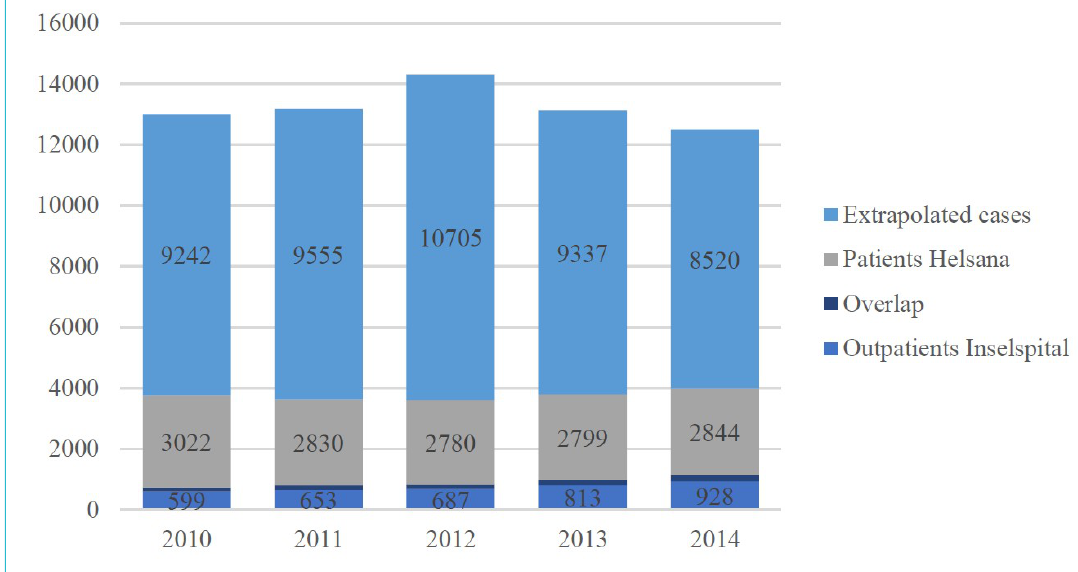
Figure 2: Identified patients with diabetes mellitus 2010–2014. 2010: 12,863 (overlap 140); 2011: 13,038 (overlap 141); 2012 14,172 (overlap 134); 2013: 12,949 (overlap 175); 2014: 12,292 (overlap 214).